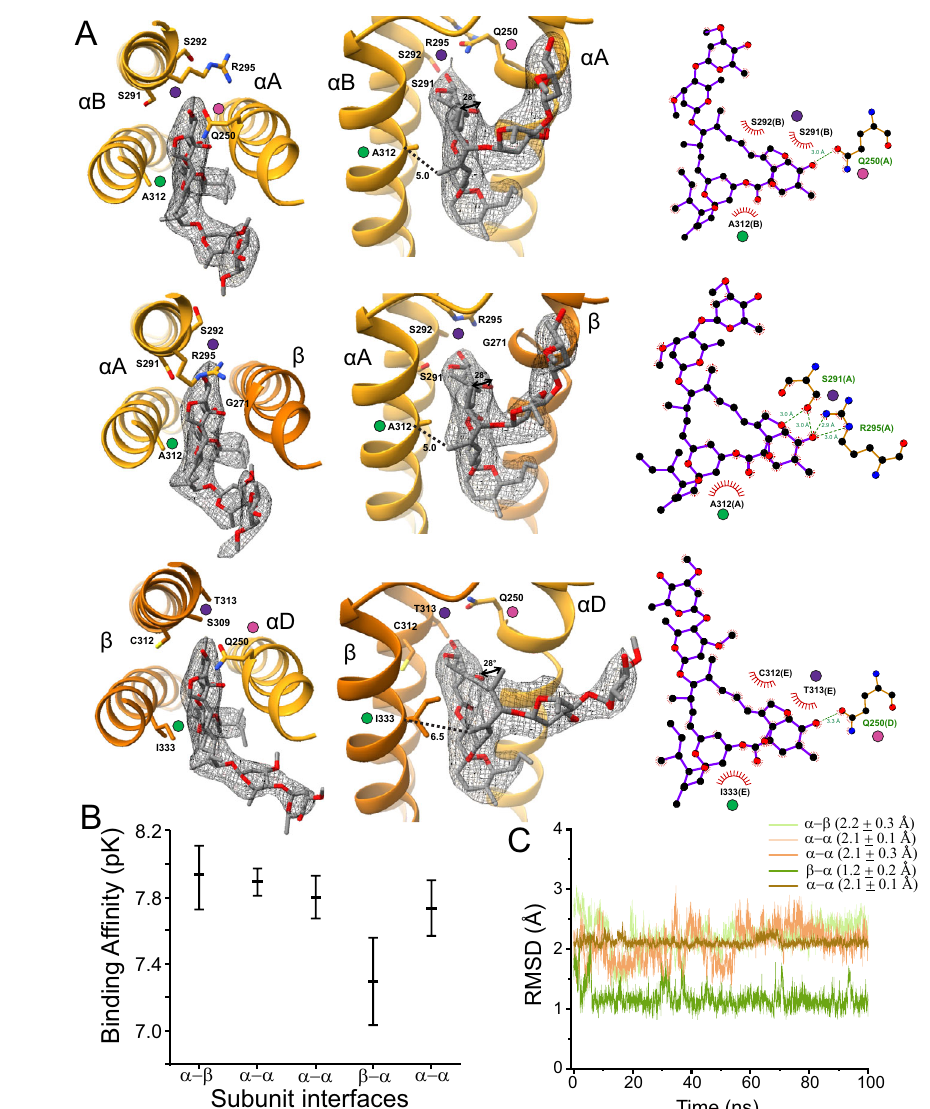
Fig. 6 | Subunit-speci fi c properties of ivermectin binding. A A select set of ivermectin interactions is shown at different angles and with LigPlot results. Map density is shown at σ =0.11. The αΒ / αΑ , αΑ / β , and β / α D interface are respectively showninthetop,middleandbottomrows.Coloreddotsshowthesamelocationin different views. The dotted lines show the distance from the C α carbon at αΑ 312 ( βΙ 333) to the methyl carbon at position 14 of the ivermectin macrocyclic lactone. The curved arrows in the middle panel of α / β show the rotation, relative to α V304 ( β V325),ofthe methylcarbon at position12 of the ivermectinmacrocycliclactone.